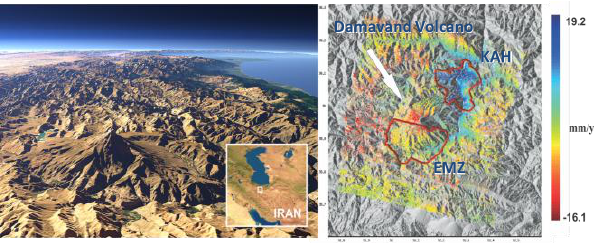
Figure 1: Left: Photo of Damavand Volcano, as viewed from east, Right: Deformation field velocity of Envisat satellite as obtained in descending. The location of the KAHR and EMZ are